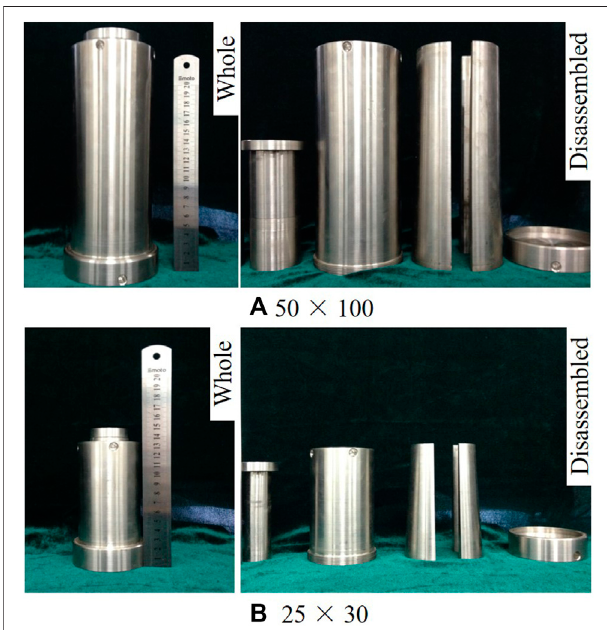
FIGURE 1 | Detachable cemented coal body mold that was designed independently. (A) 50 × 100, (B) 25 ×30.